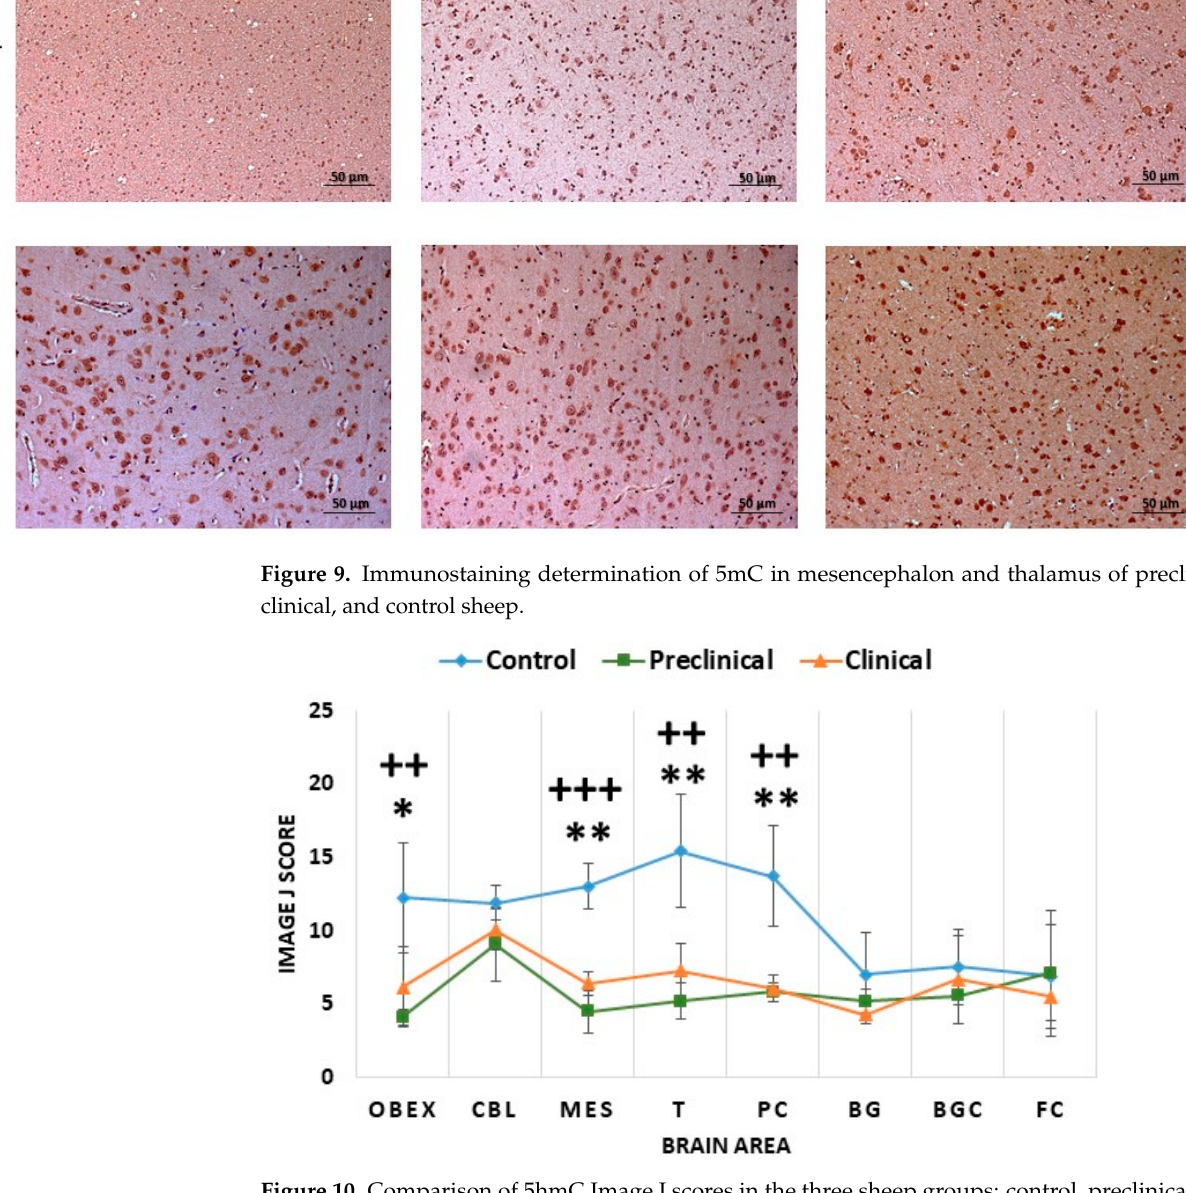
Figure 10. Comparison of 5hmC Image J scores in the three sheep groups: control, preclinical, and clinical. The analyzed brain areas were the obex, cerebellum (CBL), mesencephalon (MES), thalamus (T), parietal cortex (PC), basal ganglia (BG), basal ganglia cortex (BGC), and frontal cortex (FC). The data are presented as mean values ± SEM. * Significant difference between control and clinical sheep ( p < 0.05); ** significant difference between control and clinical sheep ( p < 0.01); ++ significant difference between control and preclinical sheep ( p < 0.01); +++ significant difference between control and preclinical sheep ( p <